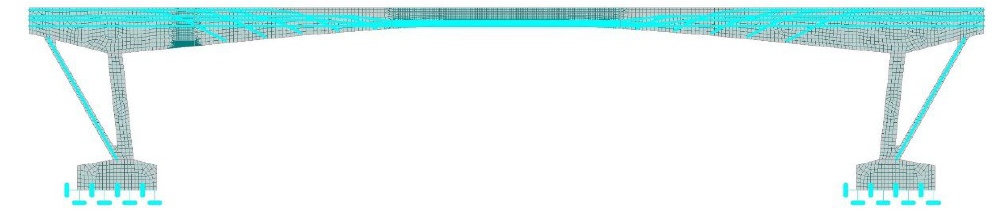
Figure 16. FE model in ATENA 2D Software.